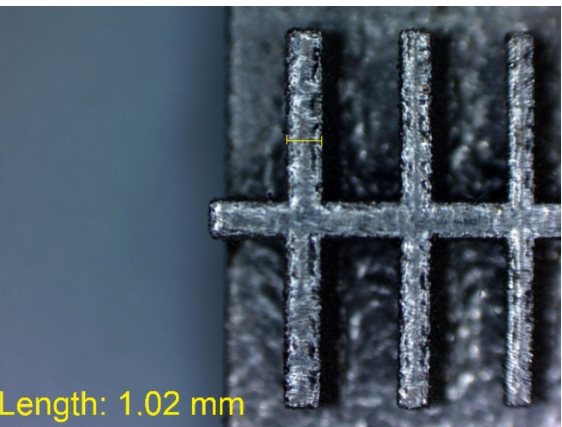
Figure 15. Measurement result for cuboidal holes and solids made in the DMLS technology: solid with a nominal width of 1 mm (L m1 = 1.02 mm).